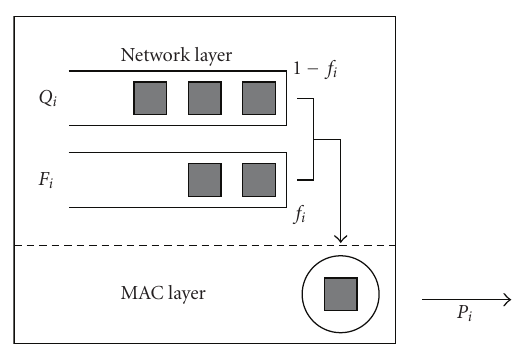
Figure 1: Network layer and MAC layer of node i